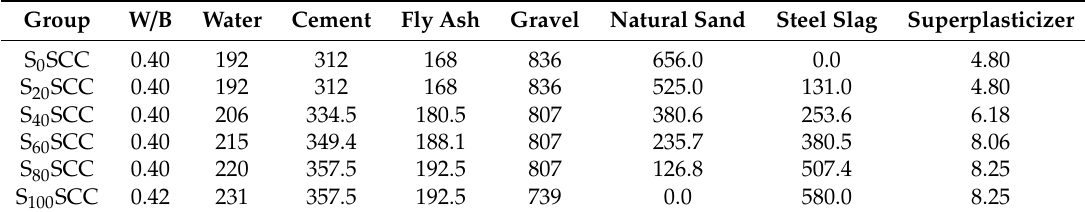
Table 9. Mix proportion of steel slag self-compaction concrete (SSCC, / kg / m 3 ).